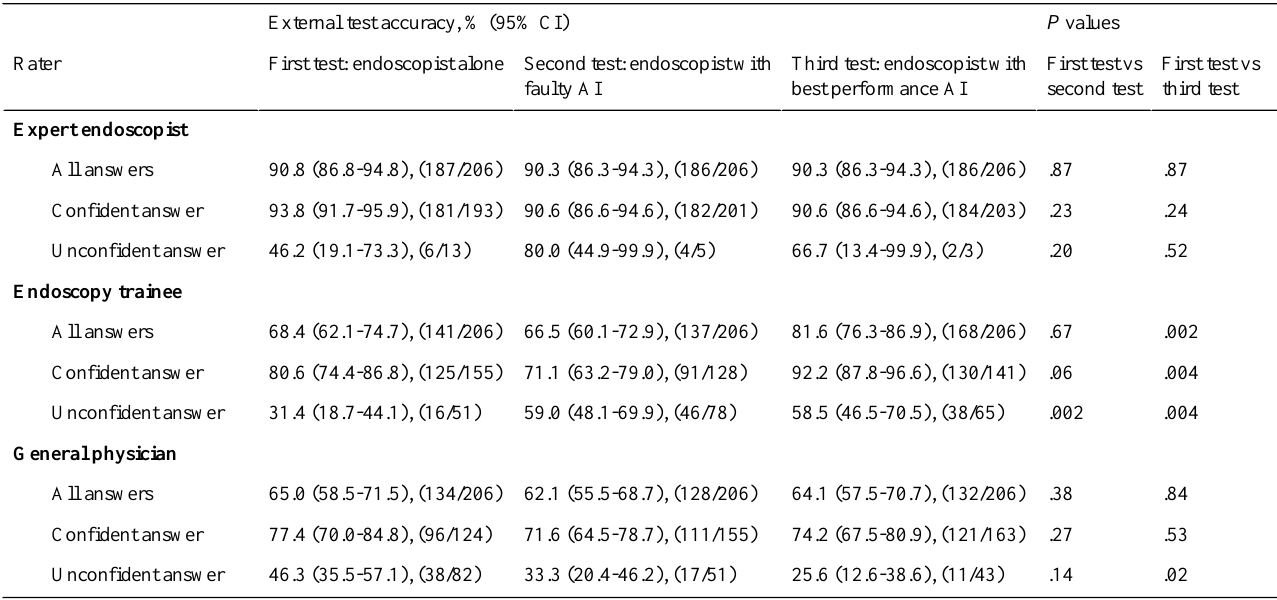
Table 3. Summary of external test accuracy in endoscopist–artificial intelligence (AI) interactions.